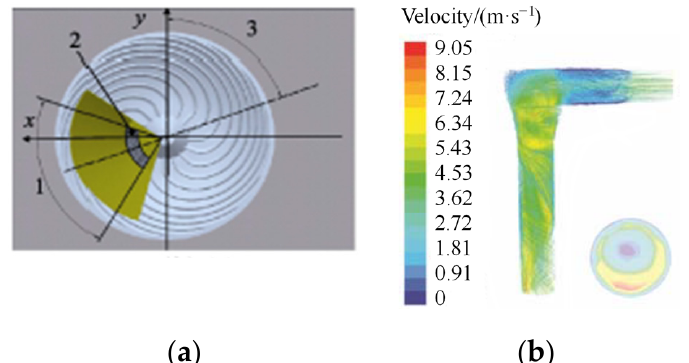
Figure 10. Simulation of fertilizer metering processes. ( a ) Simulation of fertilizing evenness [176]; ( b ) Simulation of fertilizer particle movement in the airflow [179]. 1. Feeding angle 2. Feeding zone 3. Feeding position